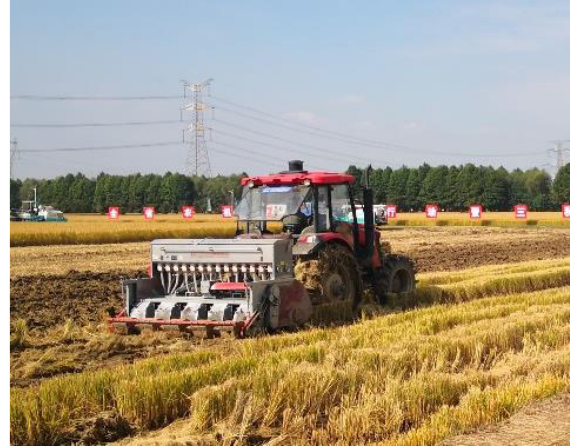
Figure 11. Picture of field validation and test scene.